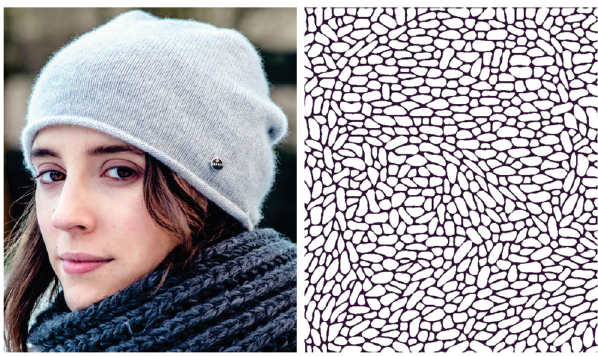
Fig. 19 Pebble layout without colorization.